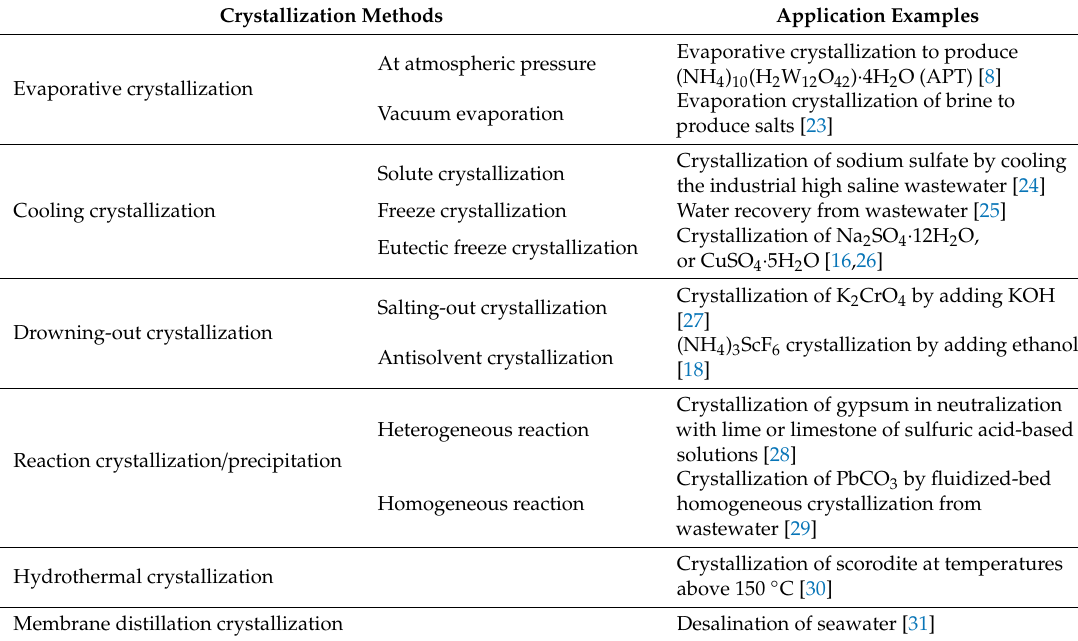
Table 3. Methods of crystallization by method of supersaturation generation.